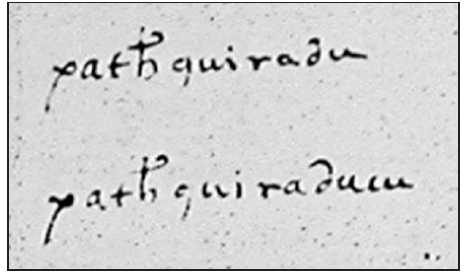
Figure 13: Patħquiradu on folio 83r of Codex 3141 (BNP